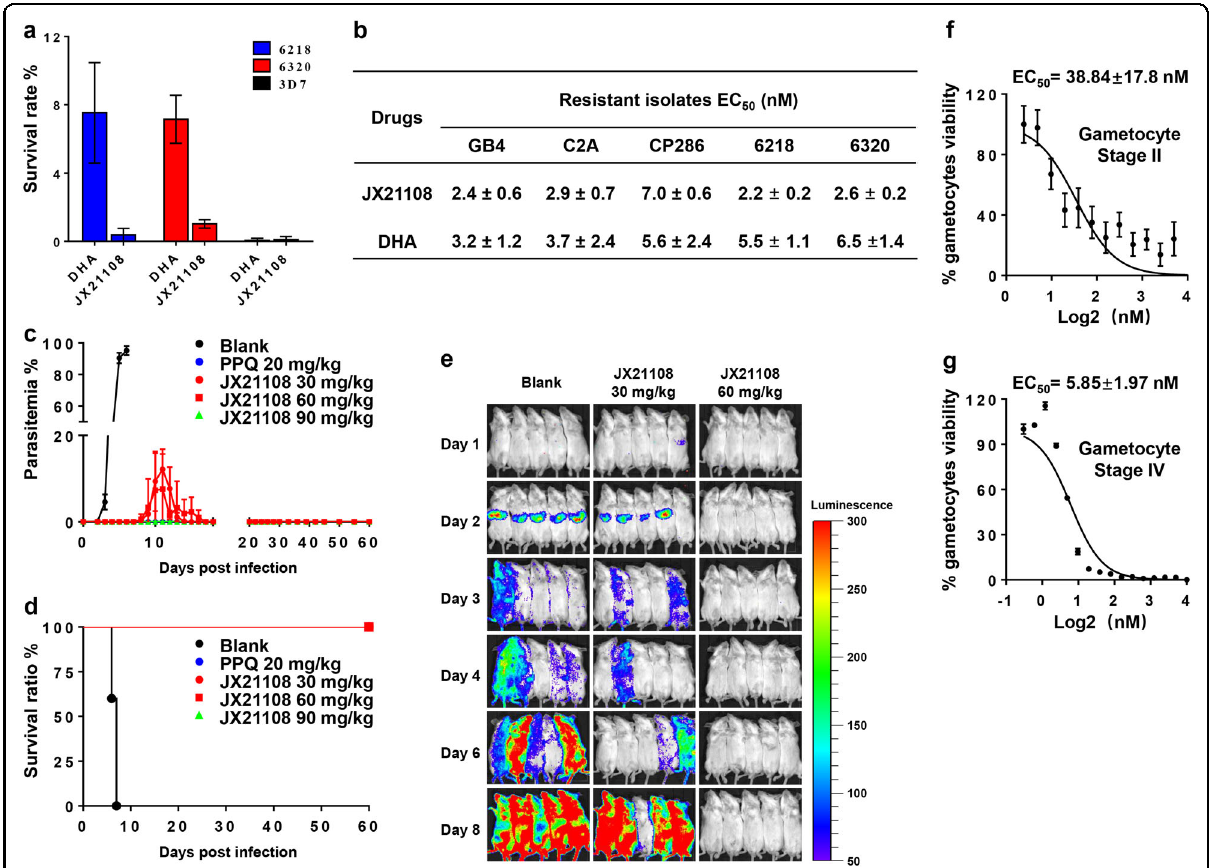
Fig. 2 Activities of JX21108 against multiple stages of the parasite life cycle. a In vitro ring-stage survival assay to assess the effect of compounds on the artemisinin- and piperaquine-resistant P. falciparum isolates 6218 and 6320. Parasitemia was calculated from at least 10,000 RBCs by microscopy. The survival rate of the drug-exposed groups was calculated as the percentage of parasitemia compared to that of the non-drug- exposed group. The concentration of DHA and JX21108 used in this experiment was 700 nM. b In vitro activity against the blood stage of various P. falciparum strains GB4, C2A, CP286, 6218, and 6320. GB4 is resistant to chloroquine, and both C2A and CP286 are resistant to pyrimethamine and chloroquine. c In vivo activity against the blood stage of P. yoelii in BALB/c mice. Five mice were used in each group. Parasitemia was calculated from at least 5000 RBCs by microscopy. Blank, untreated group; PPQ, piperaquine phosphate. The administration route was intraperitoneal (i.p.). d The survival ratio of the tested mice from the experiment described in panel c . e In vivo ef fi cacy of JX21108 against the liver stage of P. berghei . Mice were treated with a single dose of 30 or 60 mg/kg JX21108 by tail vein intravenous (i.v.) injection after sporozoite inoculation (i.v.) (day 0), and the infections were detected daily for 8 days by bioluminescence ( fi ve mice per group as shown). Blank, untreated group. f , g In vitro activity of JX21108 against gametocyte stages II and IV of the P. falciparum strain NF54. Gametocyte viability was monitored by bioluminescence. Data in a , b , c , f , and g are means ± SEM. Data in a , b , f , and g are from three biological replicates with